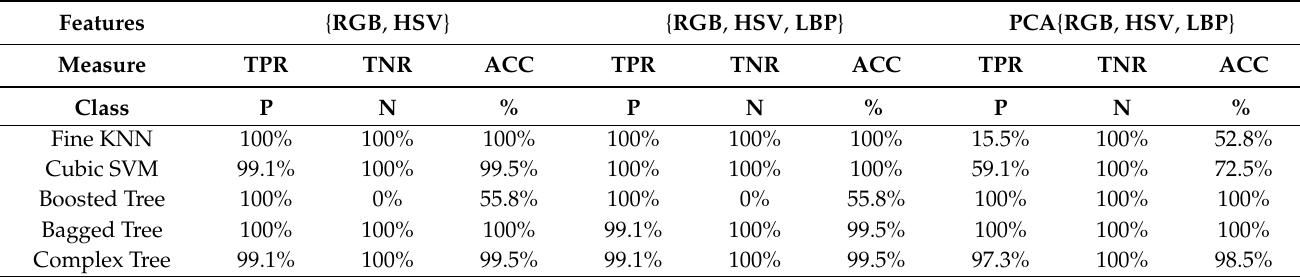
Table 8. Results obtained with different classifiers using hybrid features for image-level